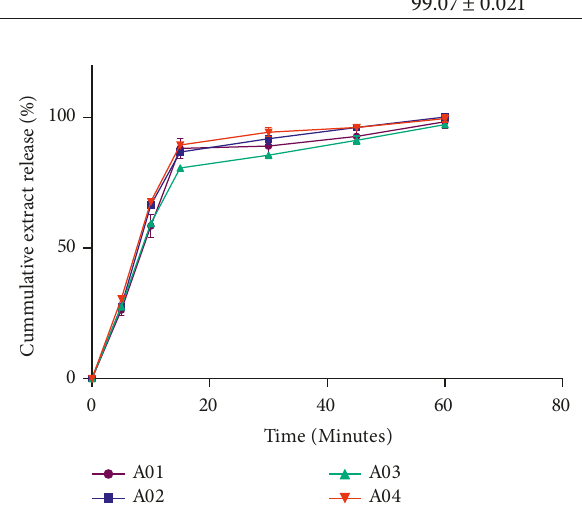
Figure 4: In vitro release profile of Antiaris africana extract from formulated capsules (mean ± S , n �